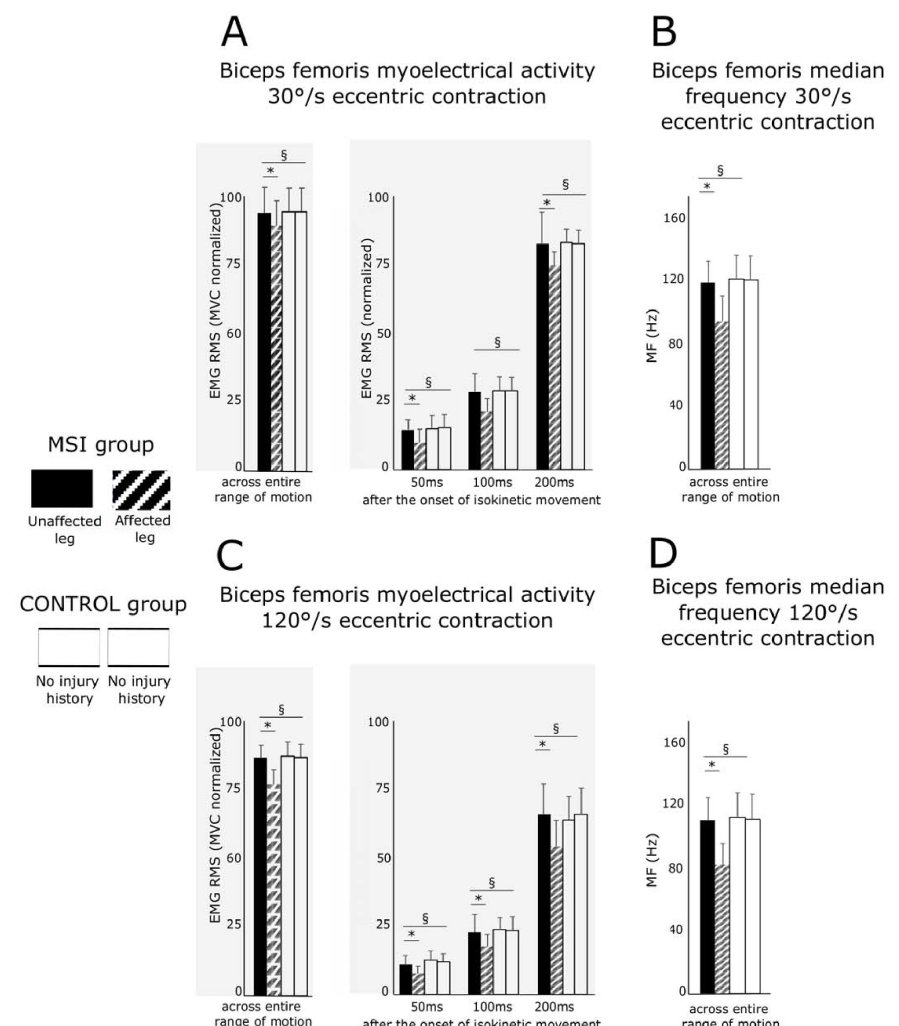
Fig 4. Grand means of myoelectrical activities. A illustrates Biceps femoris myoelectrical activity as the root mean square normalized to MVC and B the median frequency at 30˚/s during the eccentric knee flexion for the MSI and CONTROL group. Grands means for myograms are illustrated across the entire range of motion and the intervals 0–50ms, 0–100ms and 0–200ms after movement onset of the lever arm at 30˚/s speed. C illustrates Biceps femoris myoelectrical activity and D the median frequency at 120˚/s during the eccentric knee flexion for the MSI and CONTROL group. Not the reduced myoelectrical activities and frequencies for the affected leg of the MSI groups as compared to the healthy contralateral side or the CONTROL group. Values are means ± SD; § indicates significant group � leg interaction effects; � symbolizes significant pairwise differences.